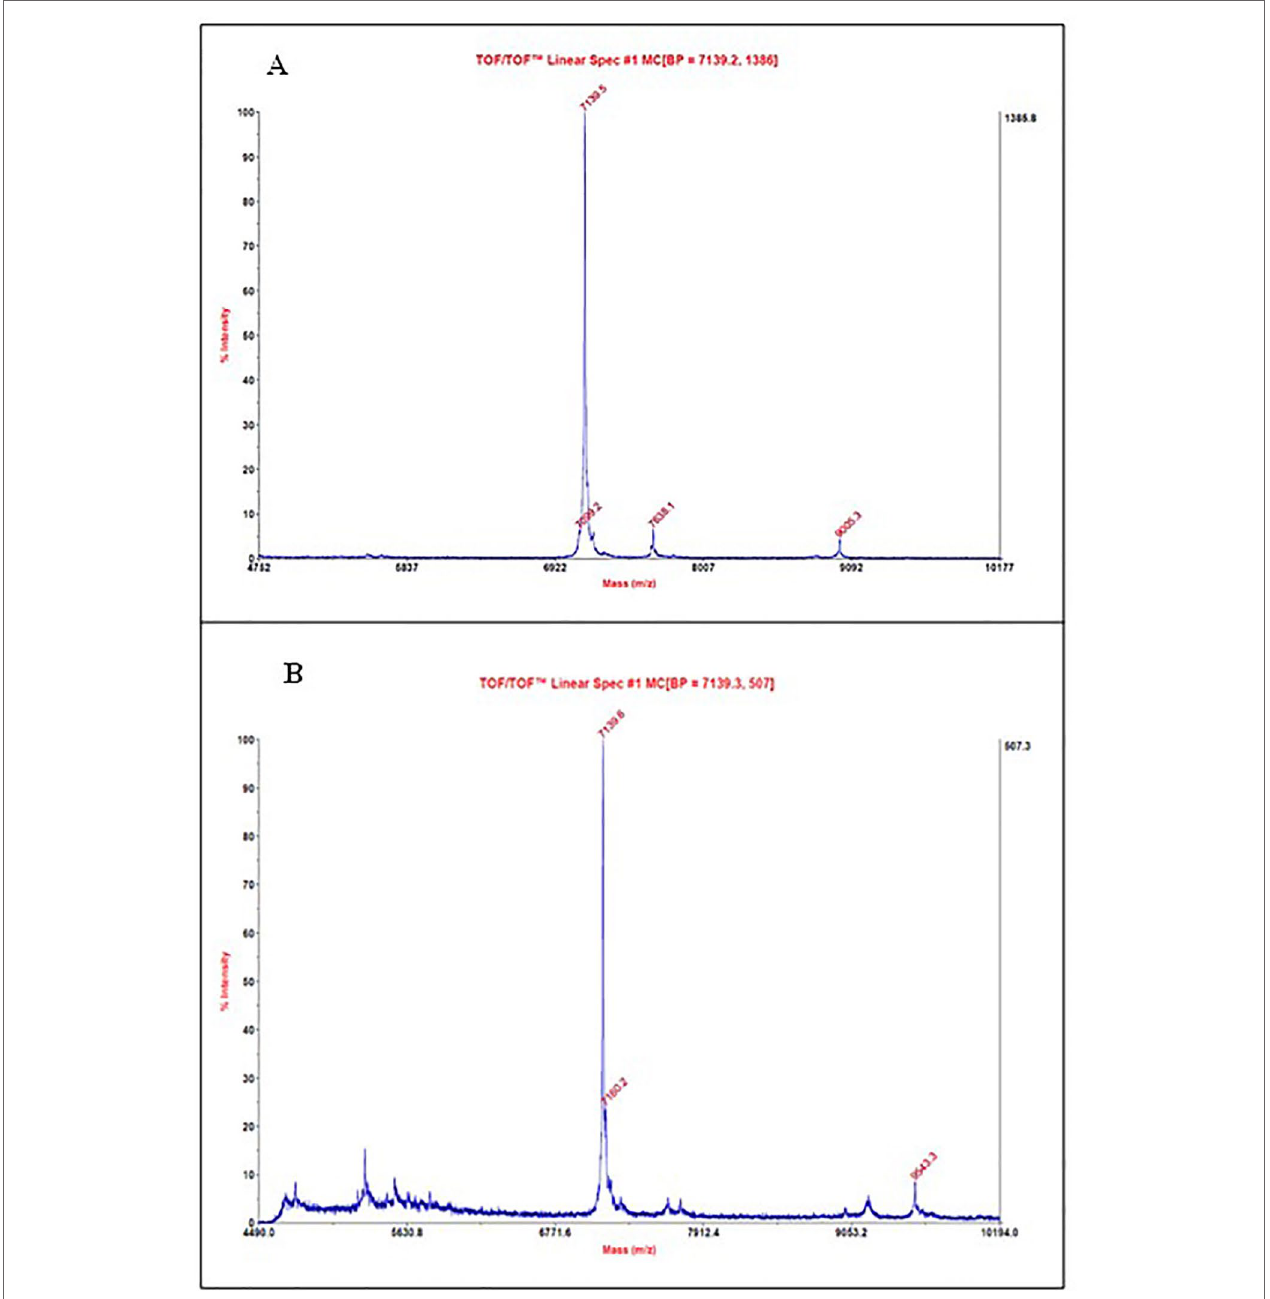
FIgUrE 8 | MALDI-TOF mass spectrum from (A) A2–A4 fractions obtained by FPLC of NLE SCI-57/M2. (B) A5–A7 fractions obtained by FPLC of NLE SCI-57/M2. Molecular masses were determined by MS using vendor-provided software (Applied Biosystems/MDS SCIEX, USA).